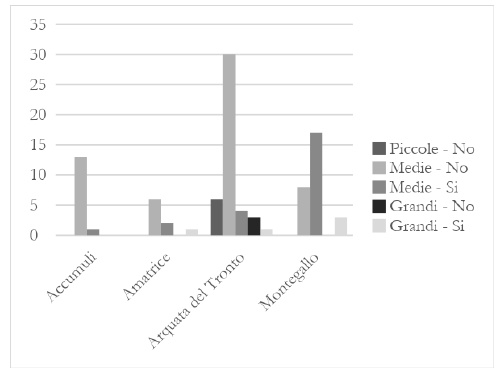
Figure 8. Relation between location and dimension and homogeneity of